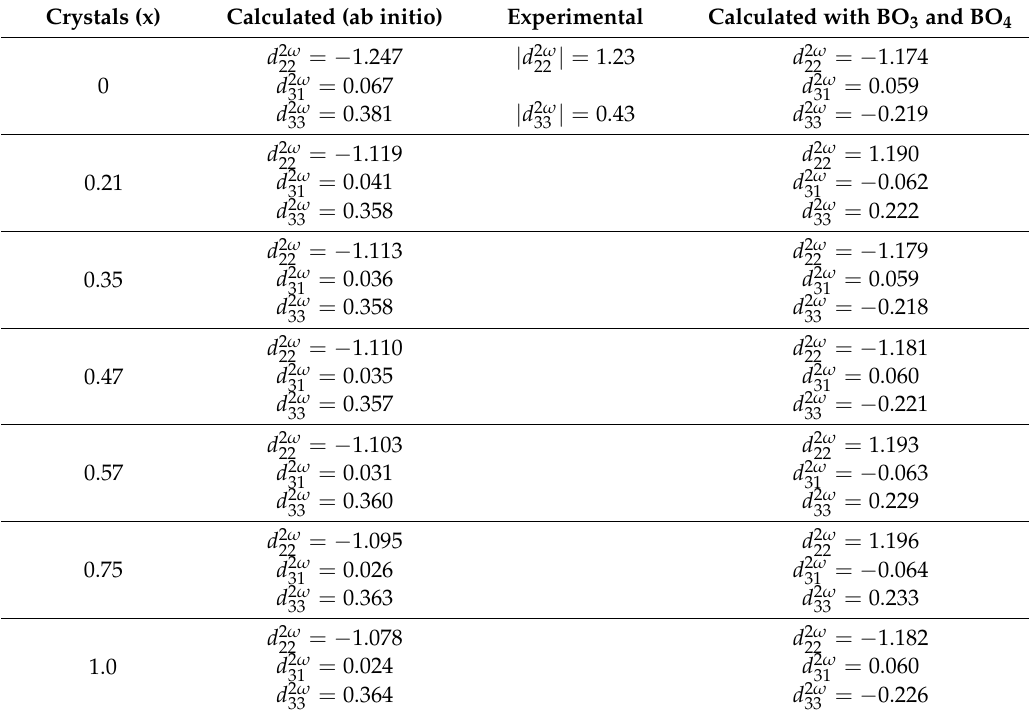
Table 4. Calculated SHG coefficients of crystals K 3 B 6 O 10 Br 1 − x Cl x (in unit pm/V).